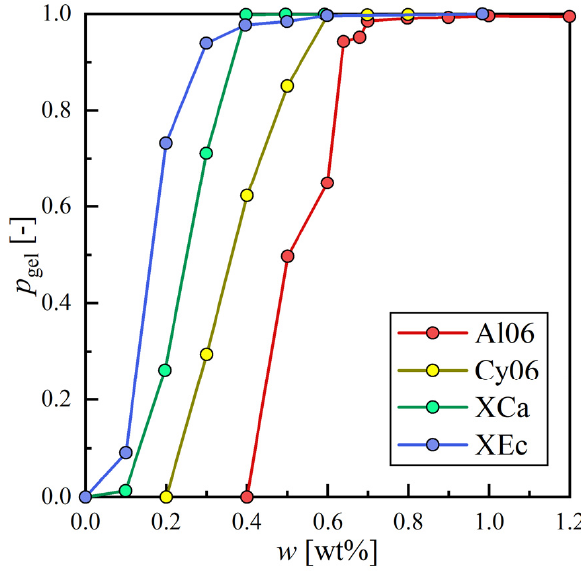
Figure 1. The degree of gelation with a weight fraction of 12HSA for hexane (Al06), cyclohexene (Cy06), hexachloroacetone (XCa), and ethyl chloroformate (Xec).